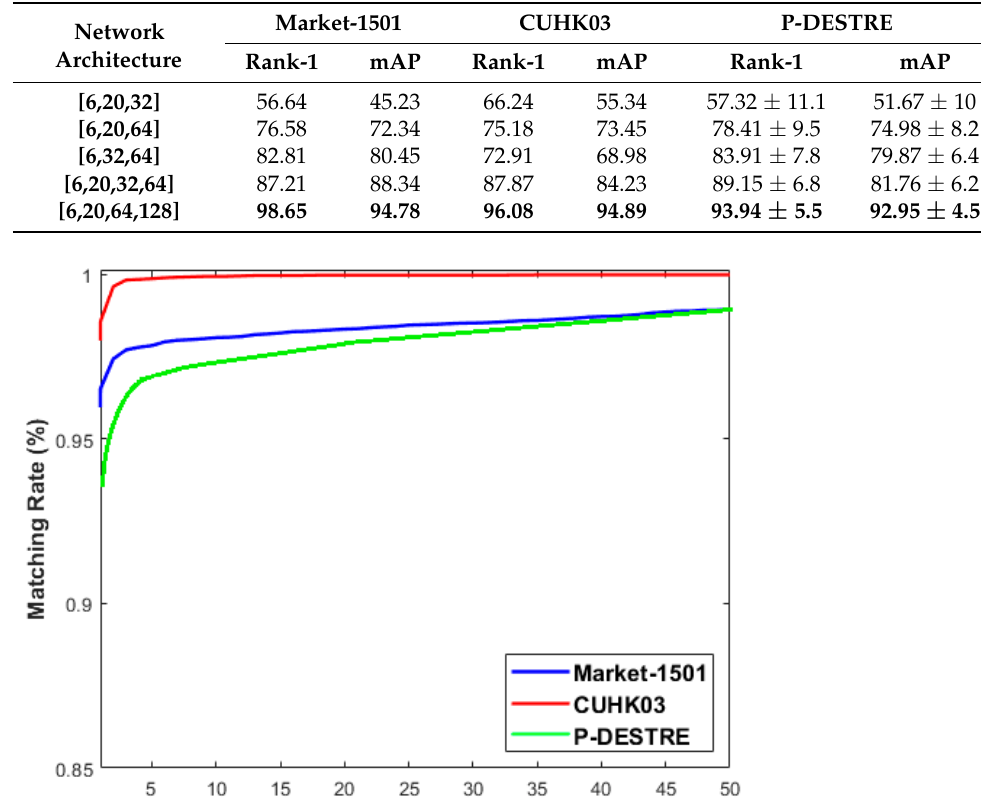
Table 4. Results for several CNN models utilizing images with a 64 × 64 pixel size from three ReID datasets. Each CNN model has 3 or 4 layers and shows the number of filters in each layer.